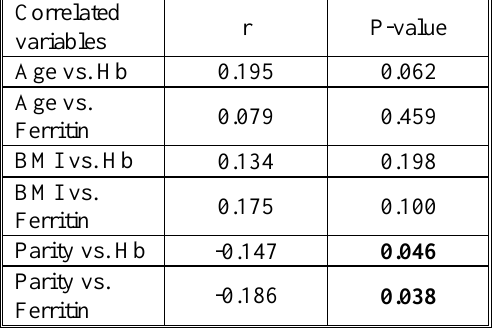
Table 3. Correlation tests of age, parity and BMI with blood Hb concentrations and serum ferritin levels of the pregnant participants .